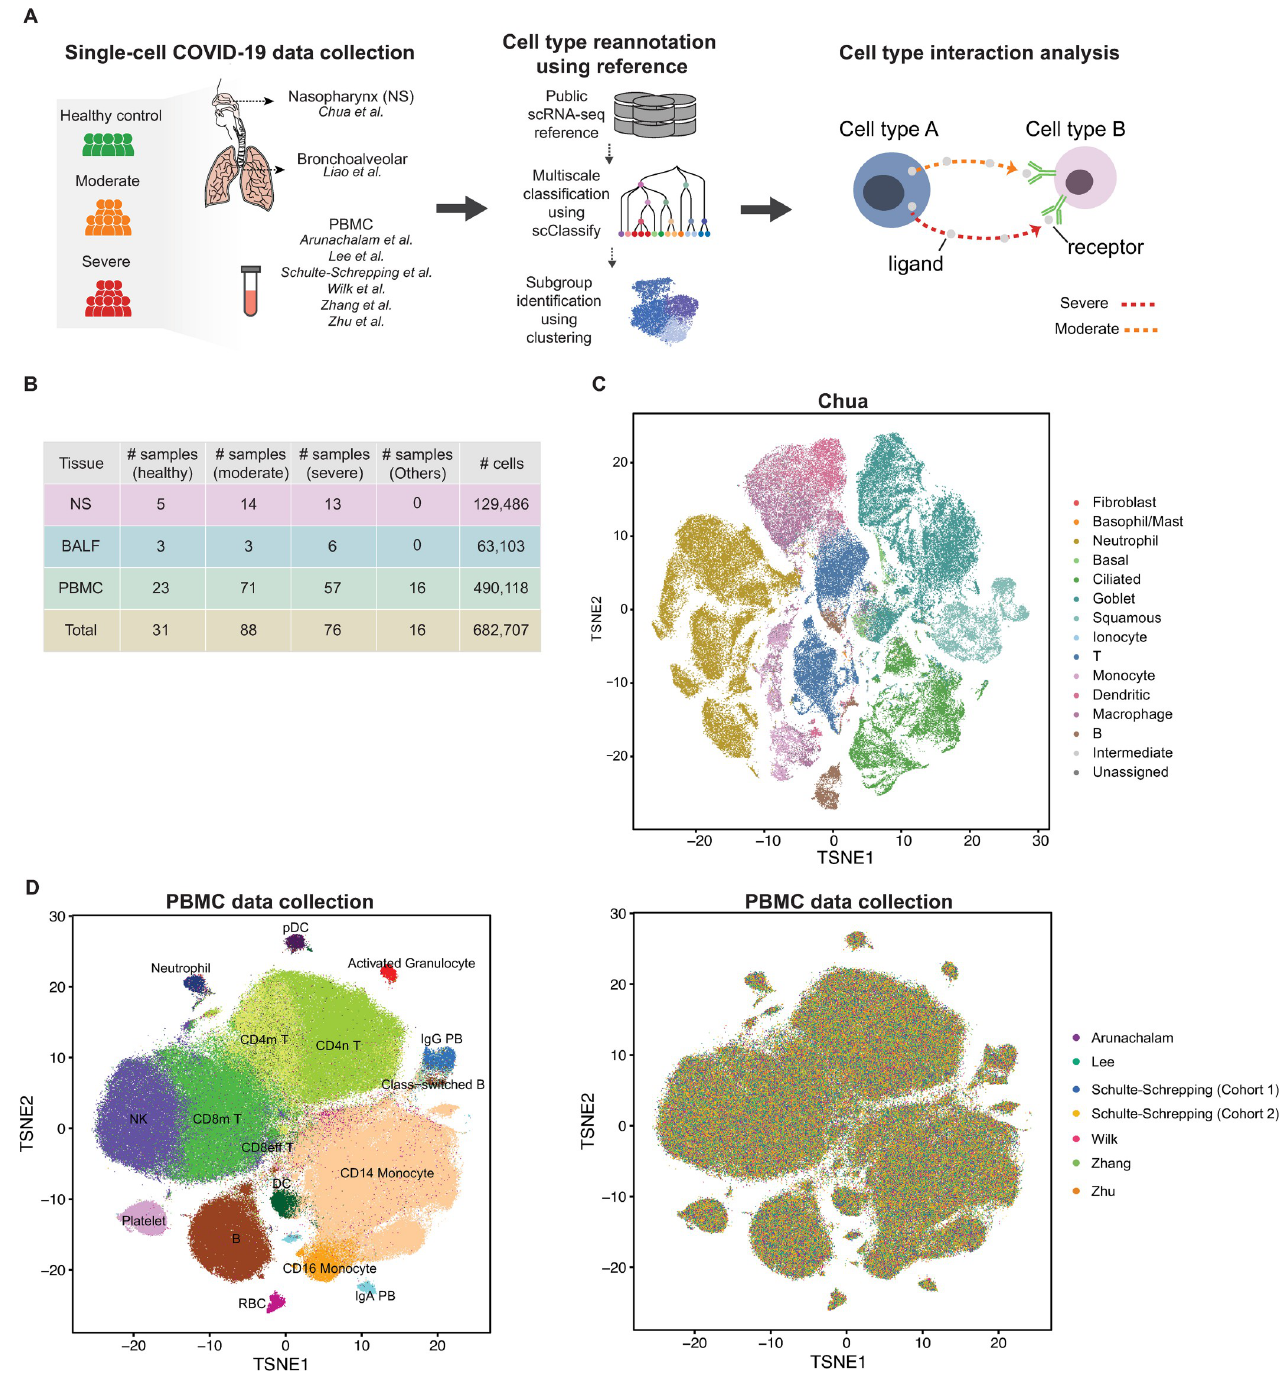
Fig 1. Integration and annotation of single-cell COVID-19 data. Schematic of the data analytic workflow. A. Summary of curated single-cell RNA-seq from COVID-19 studies from different tissues that are publicly available. B. tSNE plot illustrating cell types from all samples in the Chua dataset based on the reannotation using a modified version of the joint classification from scClassify built from four large reference datasets of human lungs. C. tSNE plot of the integrated matrix generated from scMerge illustrating cell types from all six PBMC datasets [21–26]curated for this study based on the reannotation using a modified version of the joint classification from scClassify built from Wilk dataset, colored by cell type (left panel) and dataset (right panel).